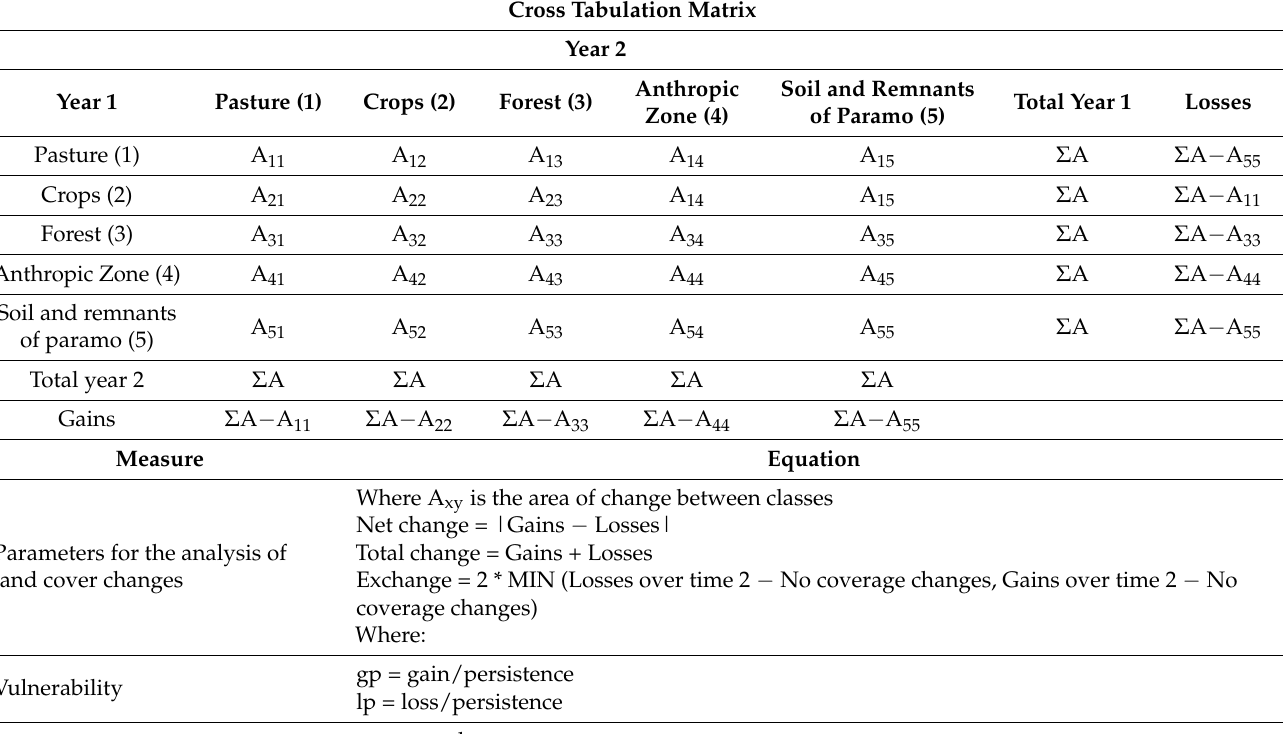
Table 1. Measures of the changes and vulnerability of the study